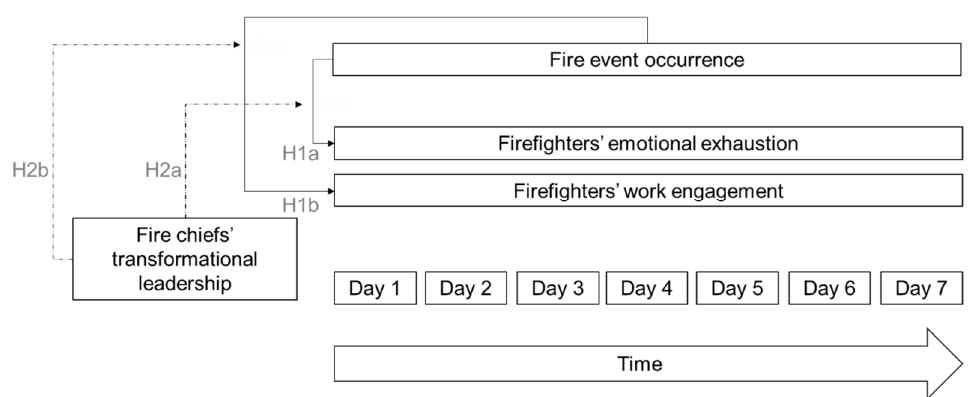
Figure 1. Summary of the research model. Fire chiefs’ transformational leadership is regarded as a moderator in the influence of the occurrence of fire events on the firefighters’ well-being (work engagement and emotional exhaustion) over the course of a full week (7 days).